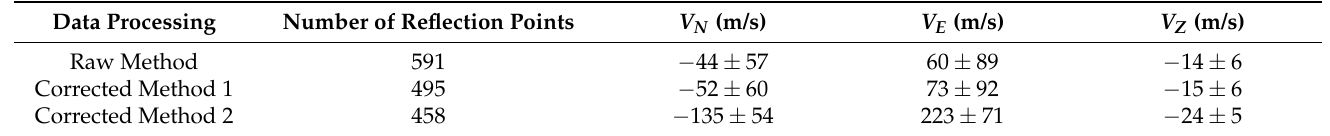
Table 3. Numbers of reflection points and drift velocity components obtained by raw